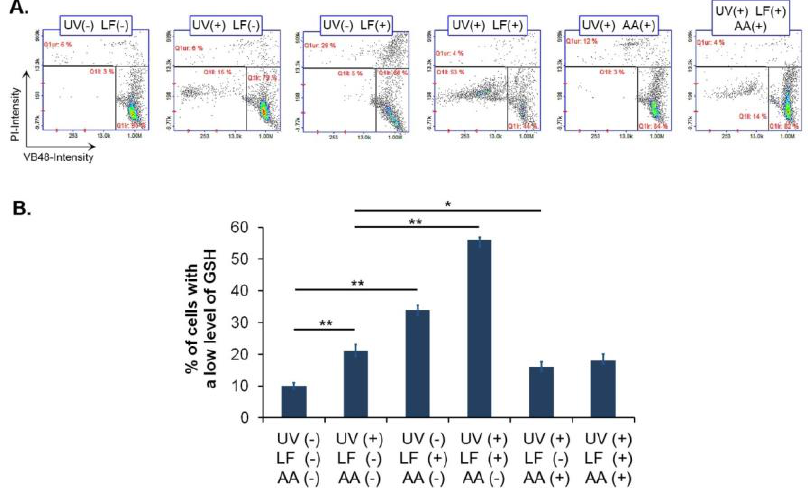
Figure 5. ( A , B ) Lomefloxacin alone as well as plus UVA radiation decreases the level of reduced glutathione in fibroblasts. Ascorbic acid (AA) reverses the phototoxic action of lomefloxacin. Cells were exposed to lomefloxacin (LF) at a concentration of 0.5 mM and UVA radiation at a dose of 1.3 J/cm 2 . The presented histograms are representative of three independent experiments. Q1ur and Q1ll-cells with a low level of reduced glutathione; Q1lr-cells with a high level of reduced glutathione. * p < 0.05; ** p <